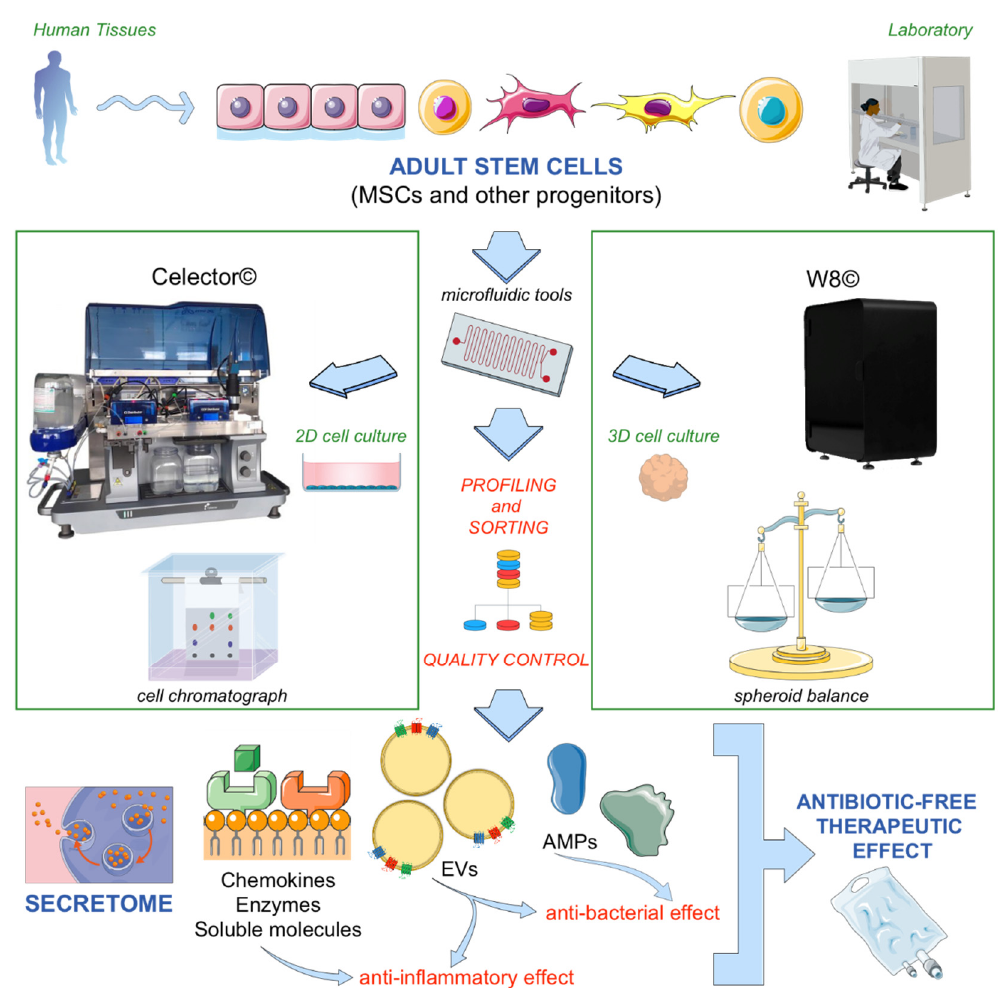
Figure 1. Biophysical characterization of stem cells for the prospective prediction of their secretome by selected microflu- idic devices.